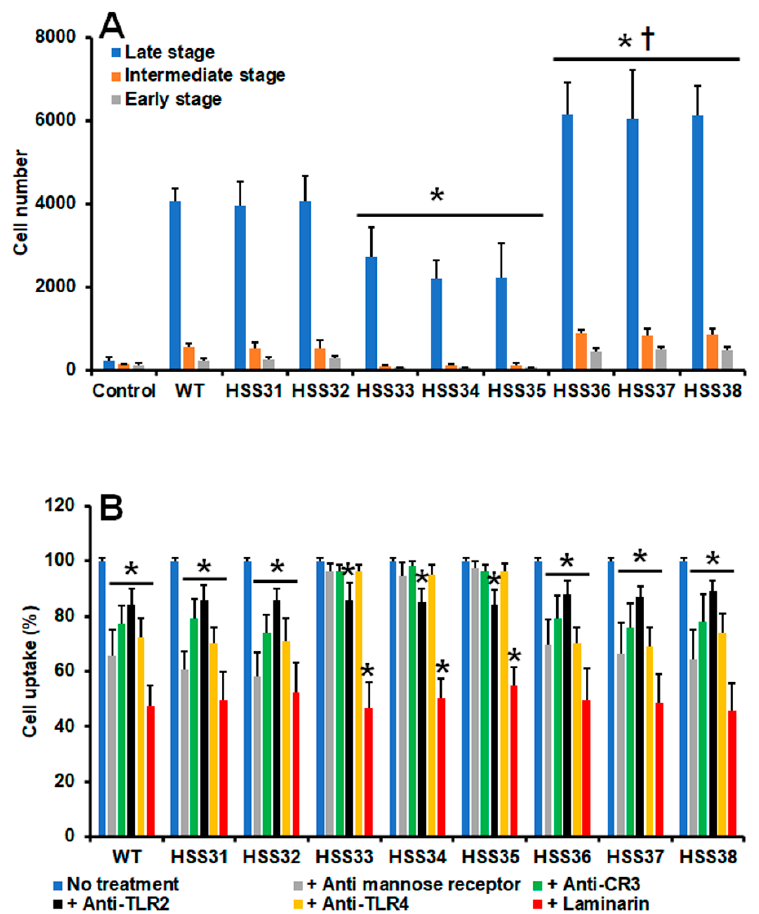
Figure 6. Phagocytosis of Sporothrix schenckii wild-type, control, and ROT2 -silenced strains by hu- man monocyte-derived macrophages. In ( A ), yeast-like cells were labeled with Acridine Orange, coincubated with human monocyte-derived macrophages at a macrophage–fungus ratio of 1:6, for 2 h at 37 °C and 5% ( v / v ) CO 2 . Human cells were gated by FACS, and 50,000 events, defined as a human cell interacting with at least one fluorescent fungal cell, were counted per sample. Control, macrophages interacting with no yeast-like cells. * p < 0.05 when compared to WT, HSS31, or HSS32 strains. † p < 0.05 when compared with HSS33, HSS34, or HSSS35 strains. In ( B ), experiments de- scribed in panel A were performed, but macrophages were previously preincubated with 10 μ g mL − 1 of any of the following antibodies: anti-mannose receptor, anti-CR3, anti-TLR2, or anti-TLR4. Alternatively, the human cells were preincubated with 200 μ g mL − 1 laminarin. In all cases, the in- teractions were performed in the presence of 5 μ g mL − 1 polymyxin B. No treatment refers to cells preincubated only with 5 μ g mL − 1 polymyxin B. Results correspond to cells in the late stage of phag- ocytosis. For all cases, 100% corresponds to the system with no treatment, and the absolute values were similar to those shown in panel A. CR3, complement receptor 3. * p < 0.05 when compared to the no treatment condition of the same strain. For both panels, data represent means ± SD from six donors assayed by duplicate.